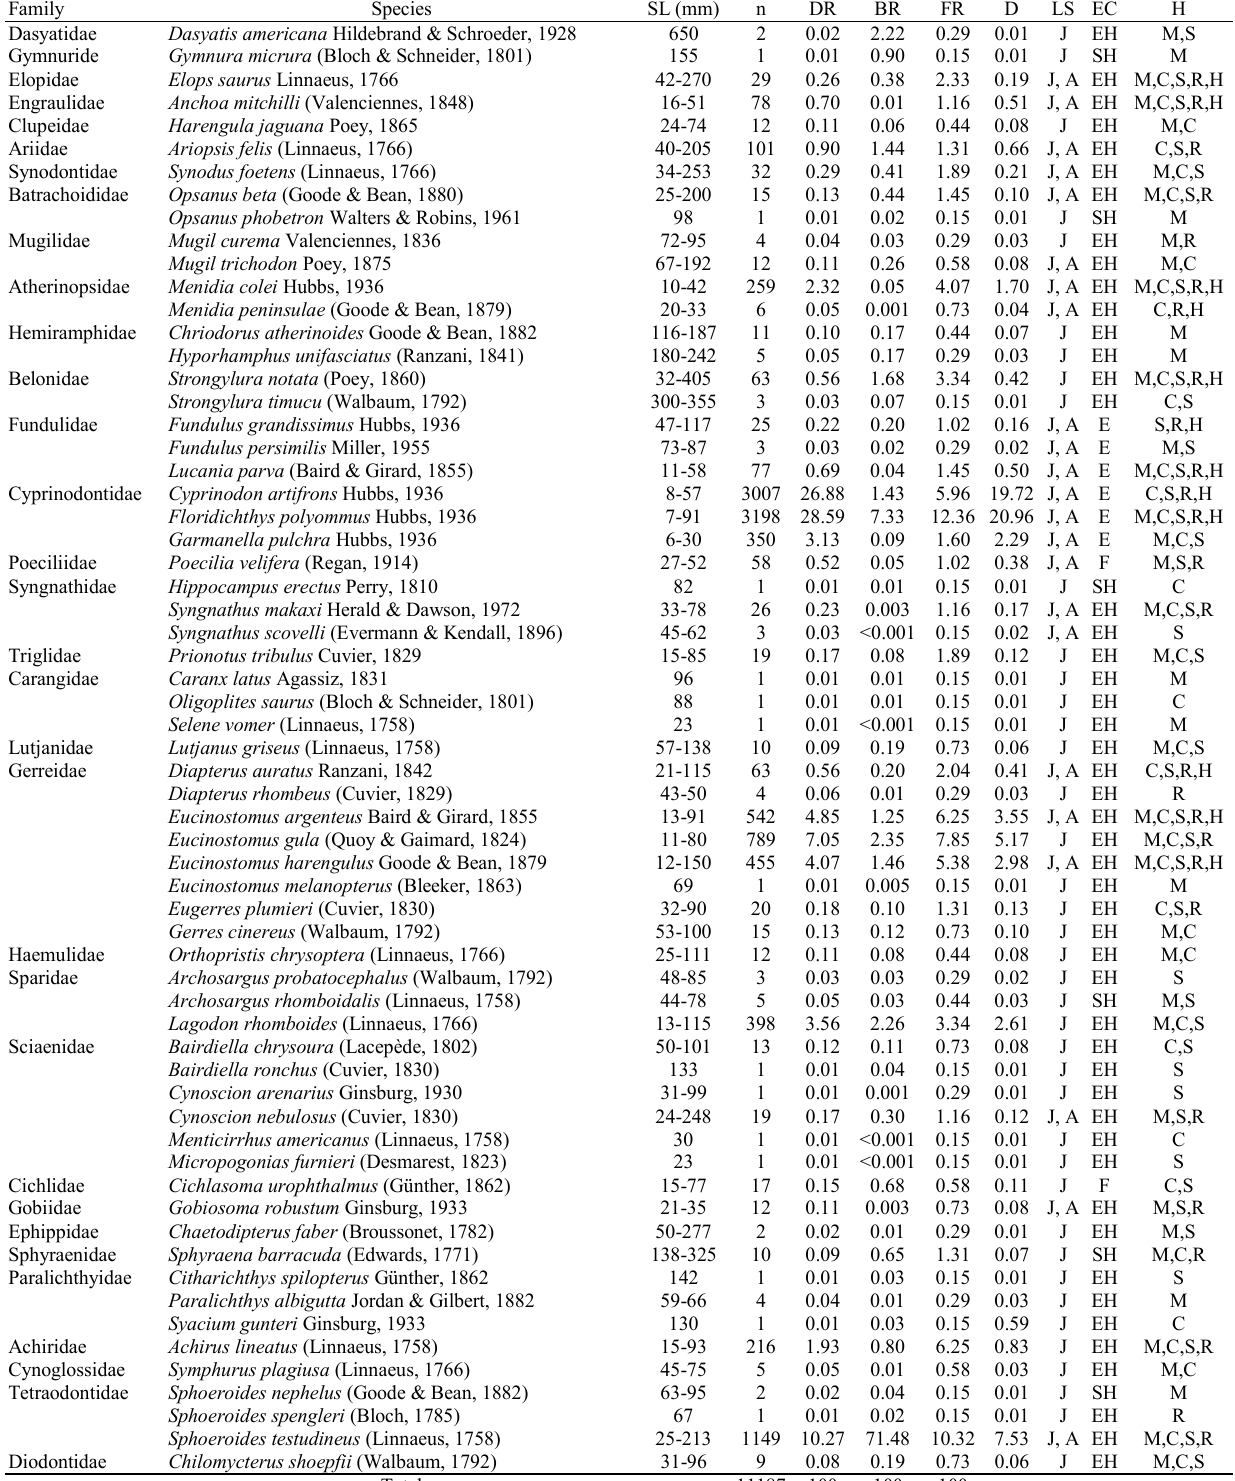
Table 3. List of the fish species recorded in río Lagartos, Yucatan, ordered according to the classification of Nelson (2006). Size ranges are specified in standard length (SL), number of individuals (n), relative density (DR), relative biomass (BR) and relative frequency (FR), mean density (D: No. 100 m -2 ), life history stages (LS; J: juveniles; A: adults), ecological category code (EC; EH: Eurihaline; SH: Stenohaline; E: Estuarine; F: Freshwater) and habitat (H; M: marine; C: channel; S: seagrass; R: rocky; H: